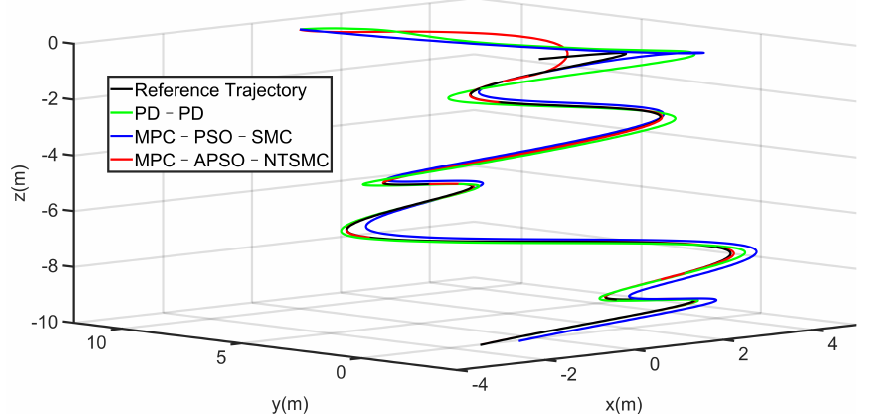
Figure 25. AUV complex curve trajectory tracking with random disturbance for Case